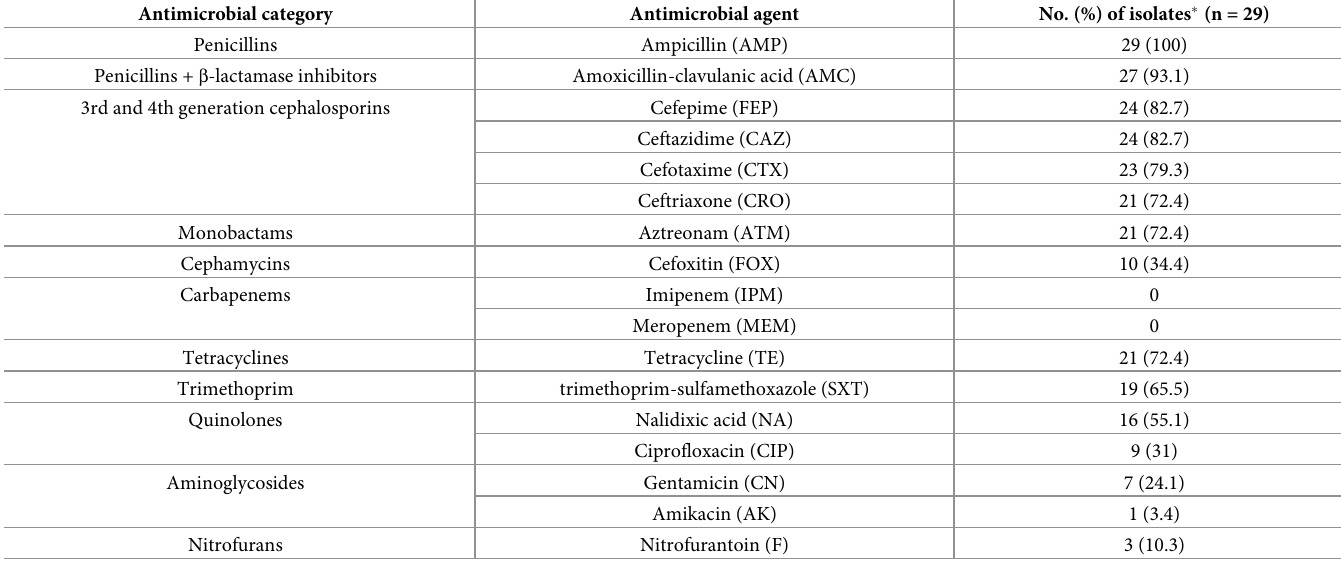
Table 9. Antimicrobial resistance of carbapenemase producing B2 UPEC isolates. Antimicrobial category Antimicrobial